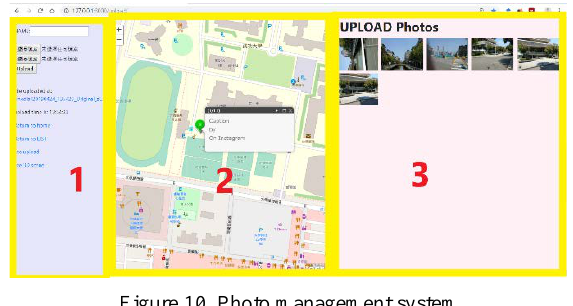
Figure 10. Photo management system